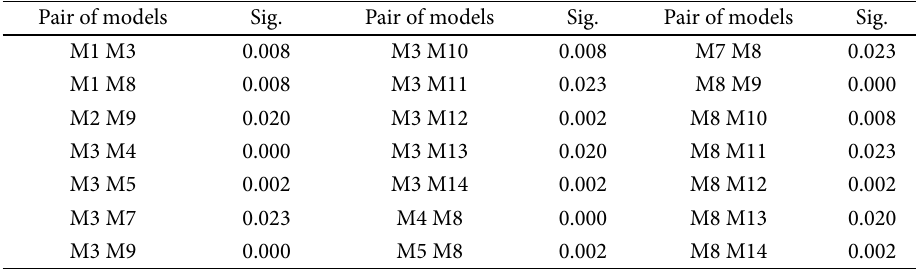
Table 10. The results of Kolmogorov-Smirnov two-sample test Pair of models Sig. Pair of models Sig. Pair of models Sig.